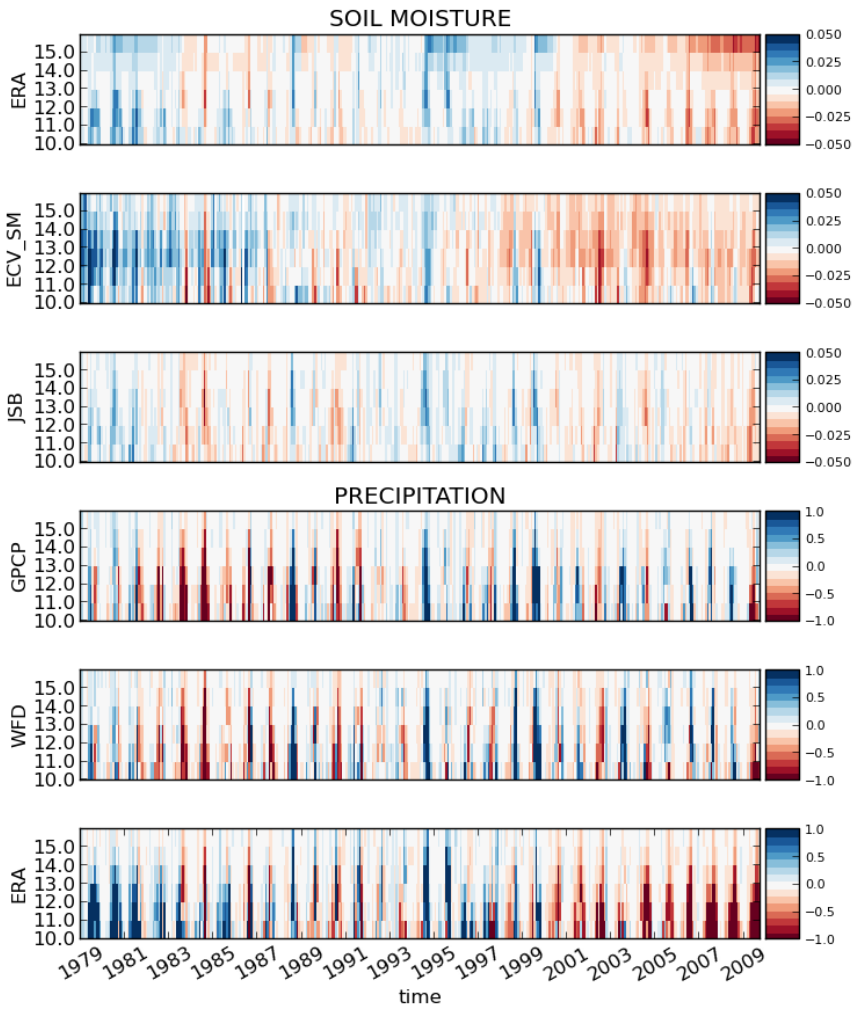
Fig. 10. Time–latitude diagrams for monthly anomalies of surface soil moisture [m 3 m − 3 ] and precipitation [mmday − 1 ] in the Sahel region (20 ◦ W–45 ◦ E, 10–20 ◦ N). Anomalies are calculated by removing the mean seasonal climatology derived from the whole time series (1979– Fig. 10. Time-latitude diagrams for monthly anomalies of surface soil moisture [ m 3 m − 3 ] and precipita- day − 1 ] in the Sahel region (20 ◦ W–45 ◦ E, 10 ◦ N–20 ◦ N). Anomalies are calculated by remov- tion [ mm ing the mean seasonal climatology derived from the whole timeseries (1979–2009).